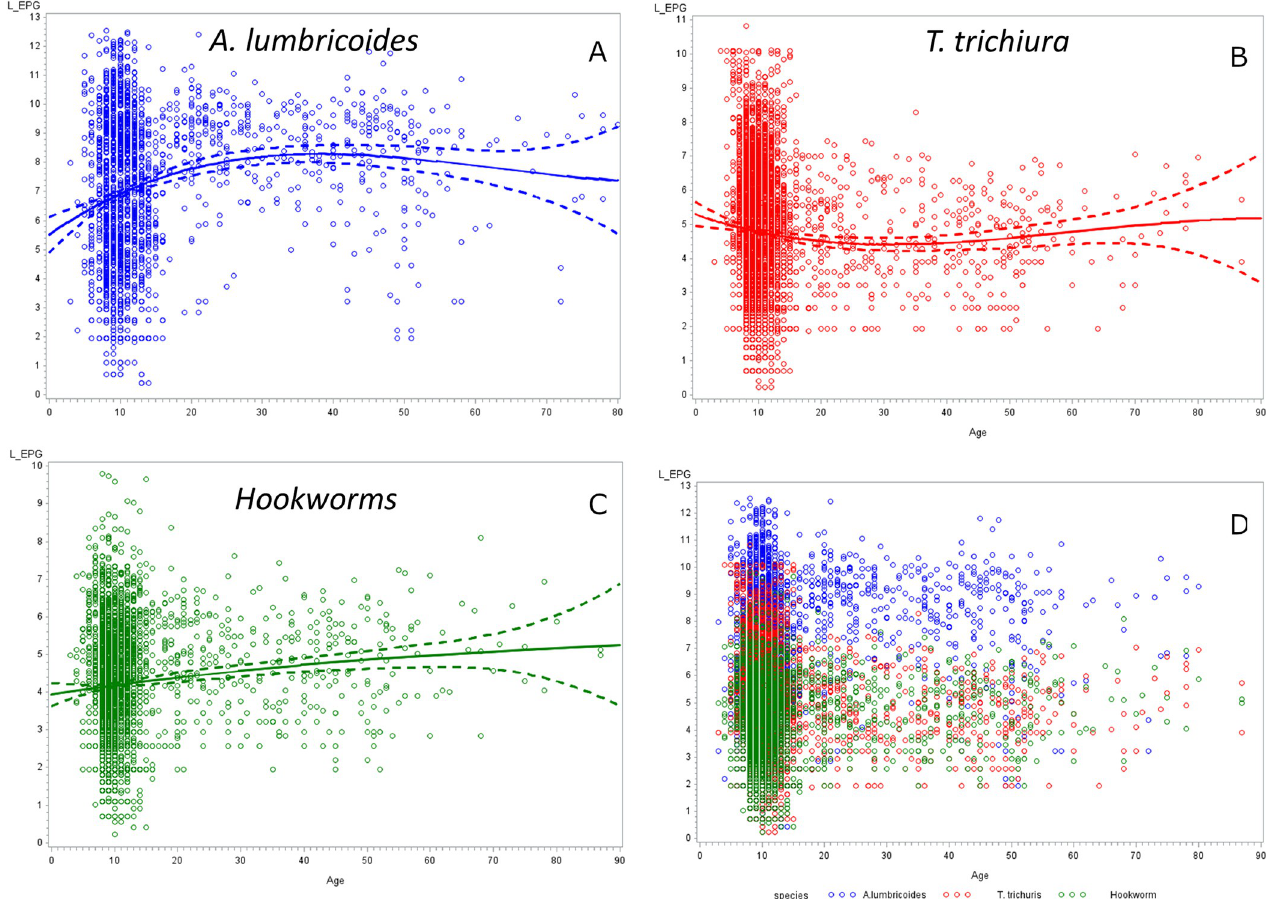
Fig 4. Age distribution of ln (EPG) by species: A. Ascaris lumbricoides , B. Trichuris trichiura , C. hookworm, D. the three species. The plain line and the dotted lines on a. b. and c. represent a polynomial fit of degree 3 with 95% confidence limits.